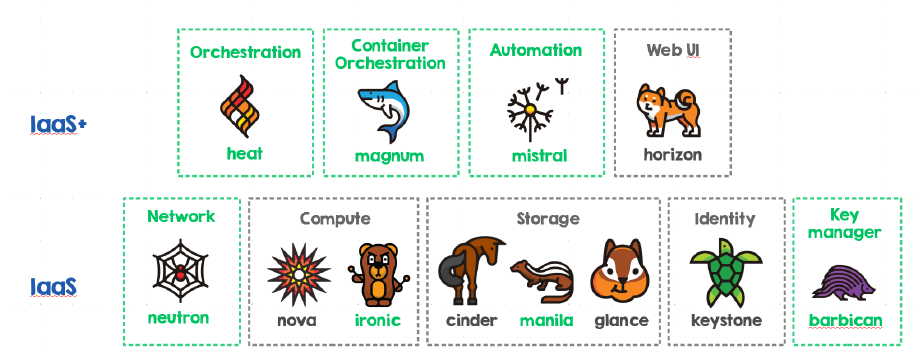
Figure 1. Current resource status of the CERN Cloud Infrastructure Service Figure 3. Current service o ff